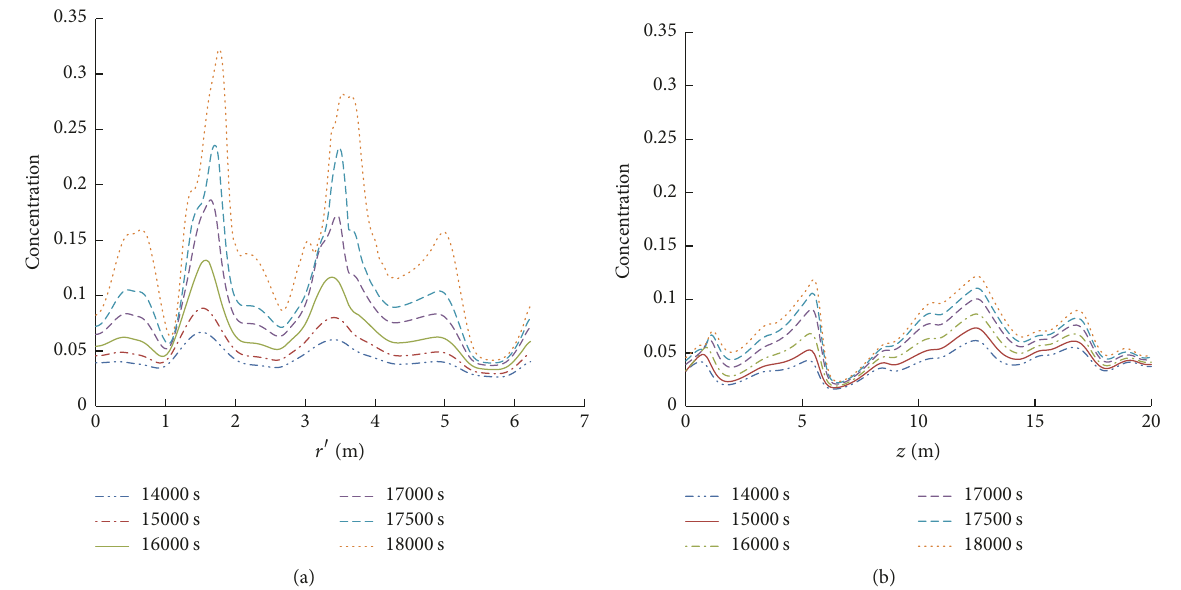
Figure 21: Evolution of particle concentration along the lines of (a) O-O 󸀠󸀠 axis and (b) O 󸀠 -A 󸀠 axis.